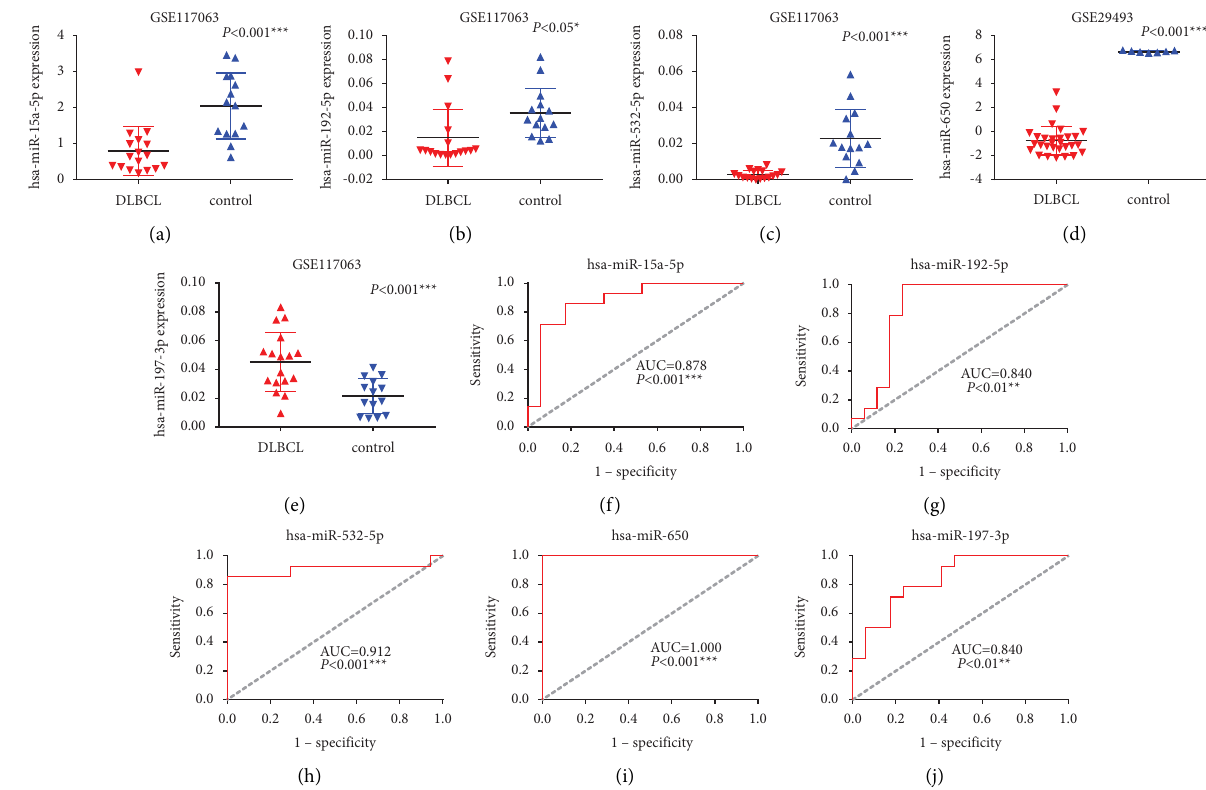
Figure 8: Scatter diagrams and ROC curves analysis for the diferential expression of miRNAs between the DLBCL and control group in GEO database. (a–d) MiR-15a-5p, miR-192-5p, miR-532-5p, and miR-650 were downregulated in DLBCL. (e) MiR-197-3p was upregulated in DLBCL. (f–j) ROC curves presented excellent diagnostic performance of each miRNA. ∗ P < 0.05, ∗∗ P < 0.01, ∗∗∗ P < 0.001.